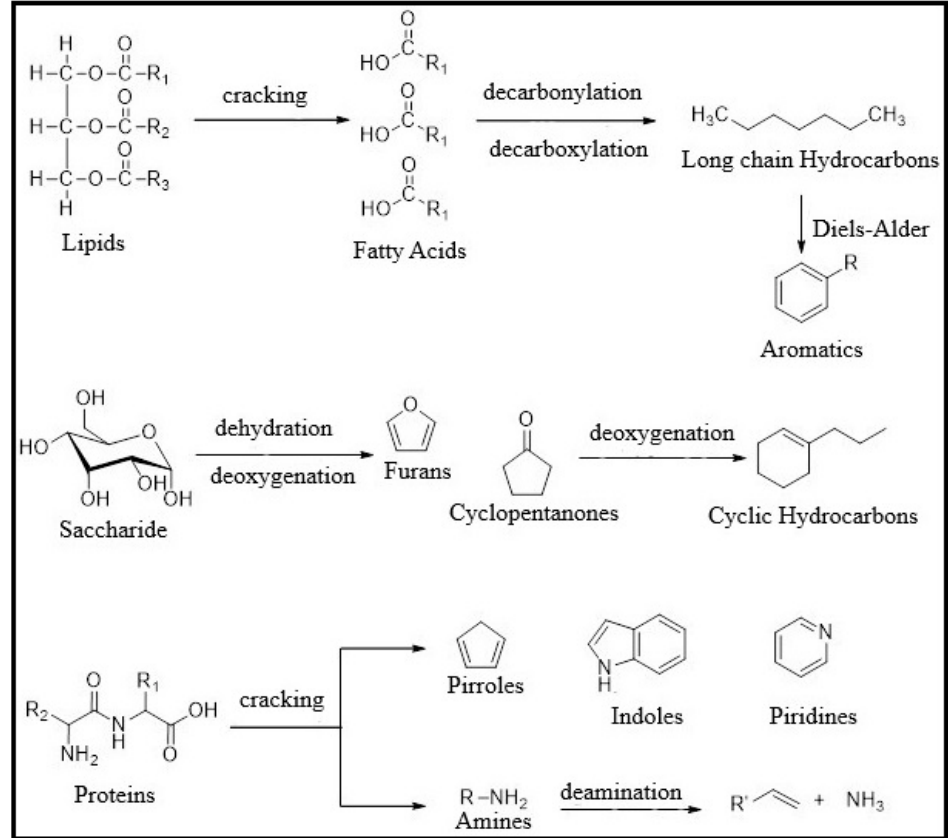
Figure 6. Proposed reaction pathway for pyrolysis of Spirulina platensis.